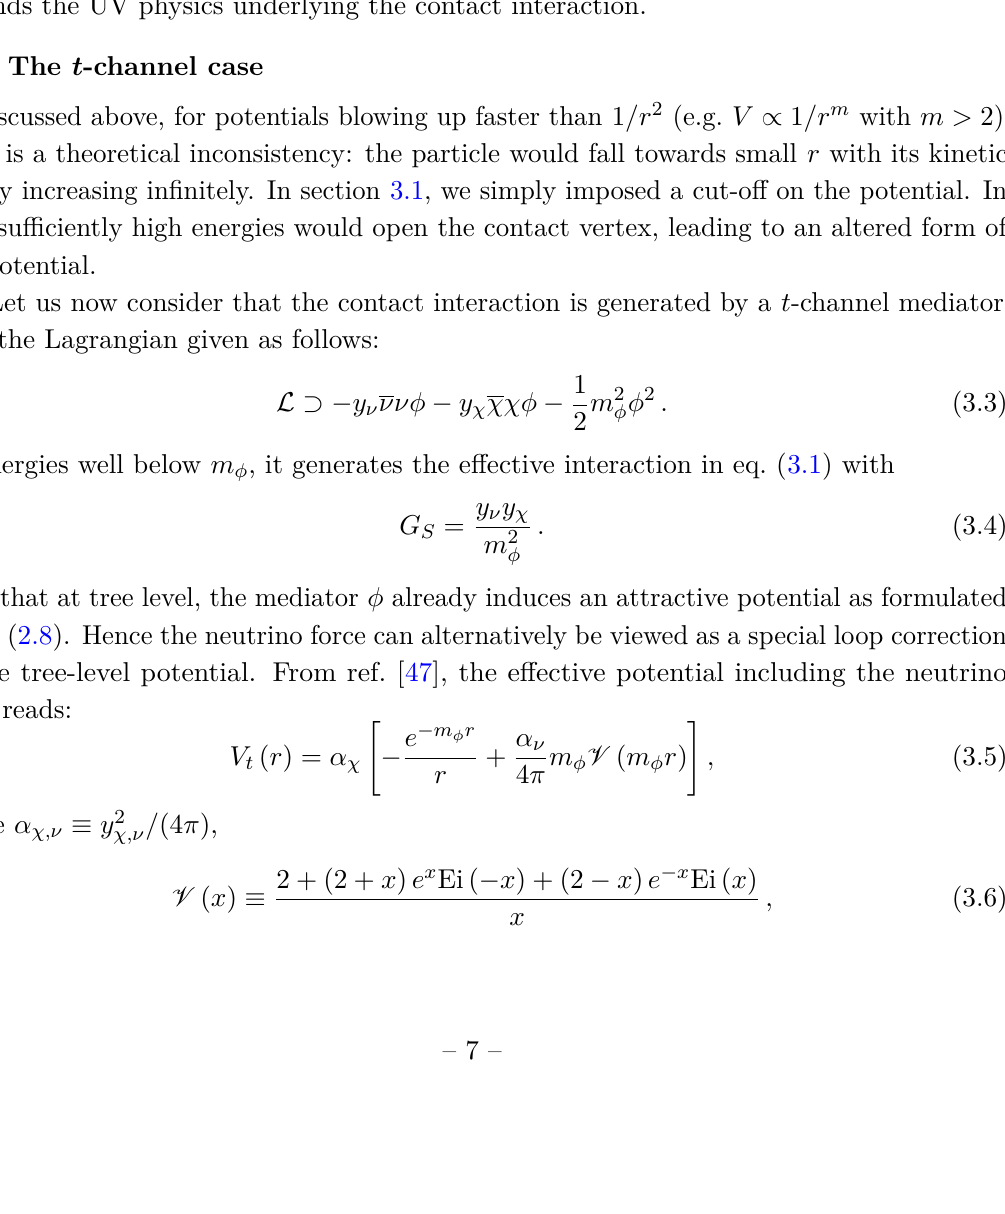
> m χ ( G − 1 / 2 < m χ S S